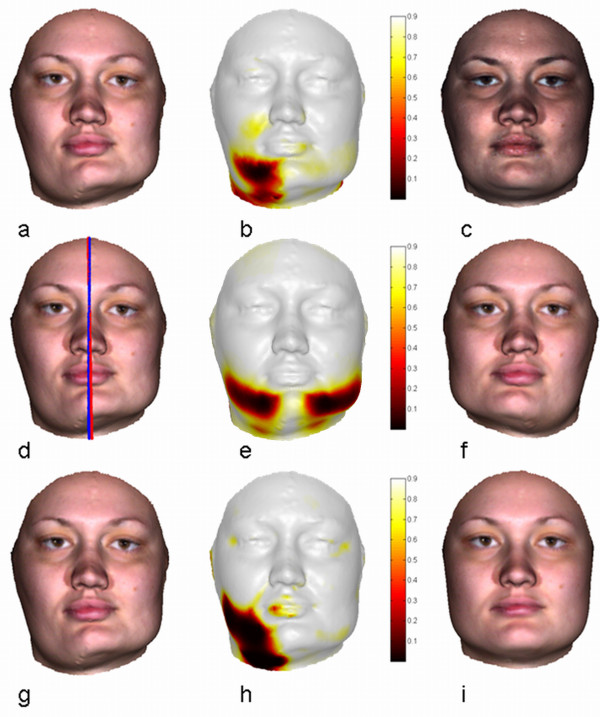
Facial form change, asymmetry and discordancy. Facial form change, asymmetry and discordancy of a 19 year old woman with a right hemimandibular hypertrophy. Top Row: Assessment of facial change due to surgical intervention. (a) Pre-surgical facial surface, representing the norm. (b) Dysmorphogram of facial change, depicting the features that changed. (c) Post-surgical facial surface. Middle Row: Assessment of facial asymmetry. (d) Original facial surface being the norm. With a robustly obtained mid-facial line (blue) and skewed symmetry line (red) obtained with an original Procrustes-fit. (e) Dysmorphogram of facial asymmetry, depicting the asymmetrical features. (f) Mirrored facial surface, according to the blue mid-facial line. Bottom Row: Assessment of facial discordancy (g) Pre-surgical facial surface to assess (i) Norm-equivalent of the Pre-surgical facial surface, being the norm (h) Dysmorphogram of facial discordancy, depicting the features that are considered abnormal compared to a normative reference population.